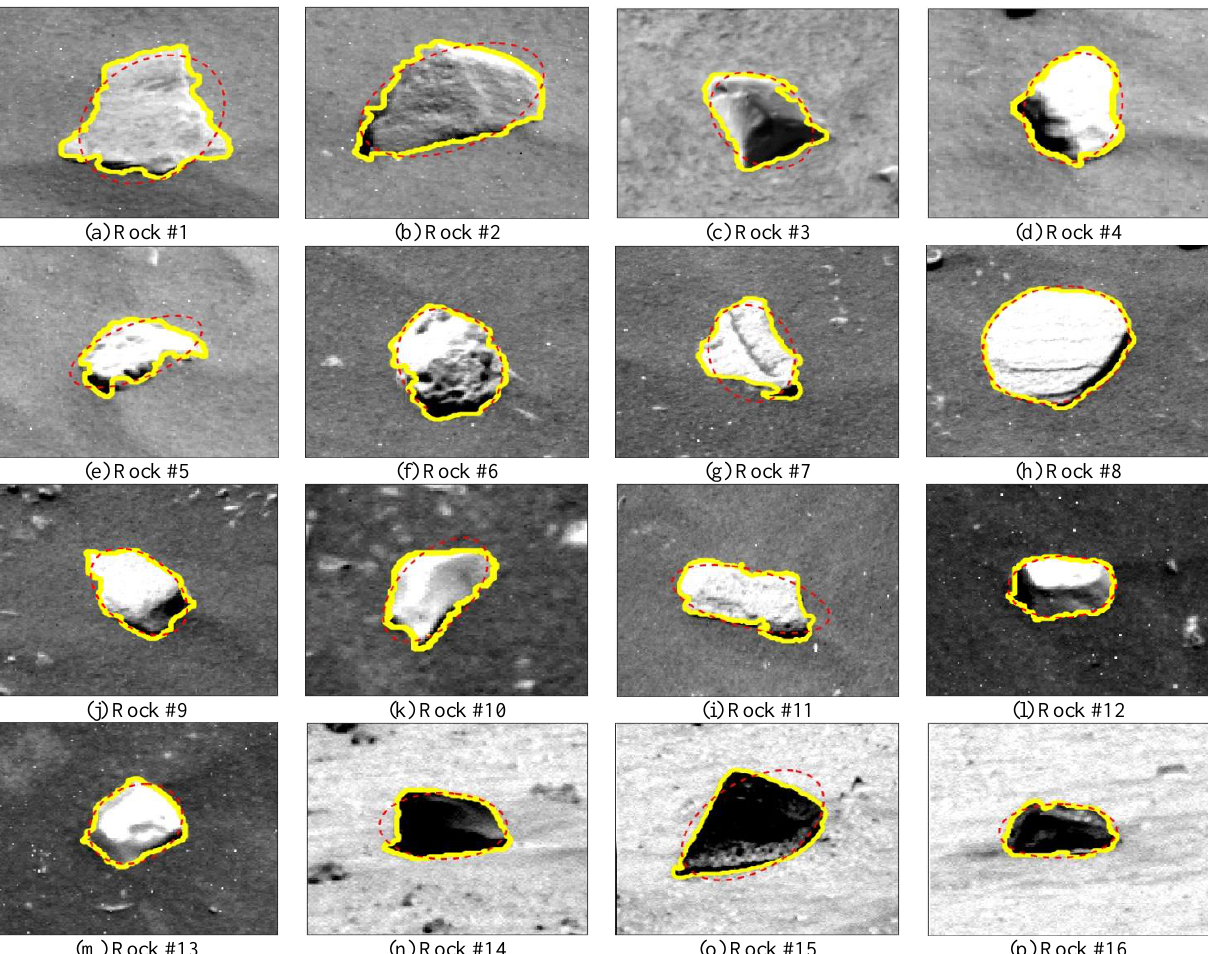
Fig. 4 Extracted rocks and their associated fitting ellipses. Fitting ellipse: red dashed lines, rock boundary: yellow